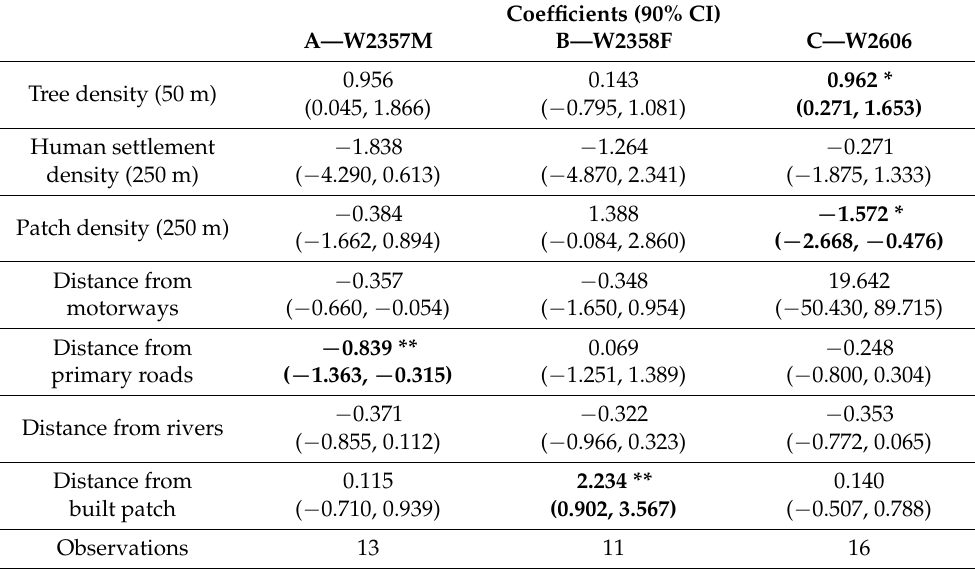
Table 4. Output of the fitted individual-based models. For each individual model, the explanatory variables, parameter estimates (and 90% confidence interval), and significance levels (in bold when significant) are reported. The number of resting sites used to fit each model is reported